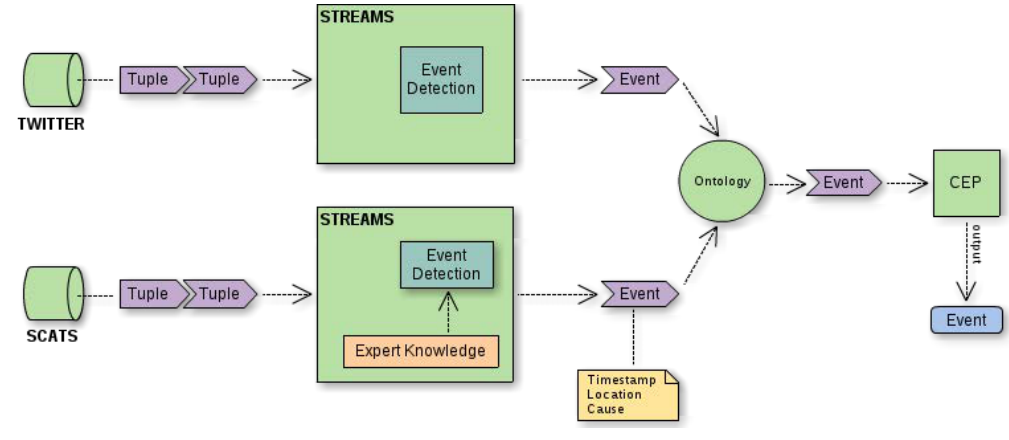
Figure 8. INSIGHT Architecture for Event Detection from Heterogeneous Data Streams Exemplified with two Input Streams Twitter and Traffic Loop Data Derived by SCATS (compare